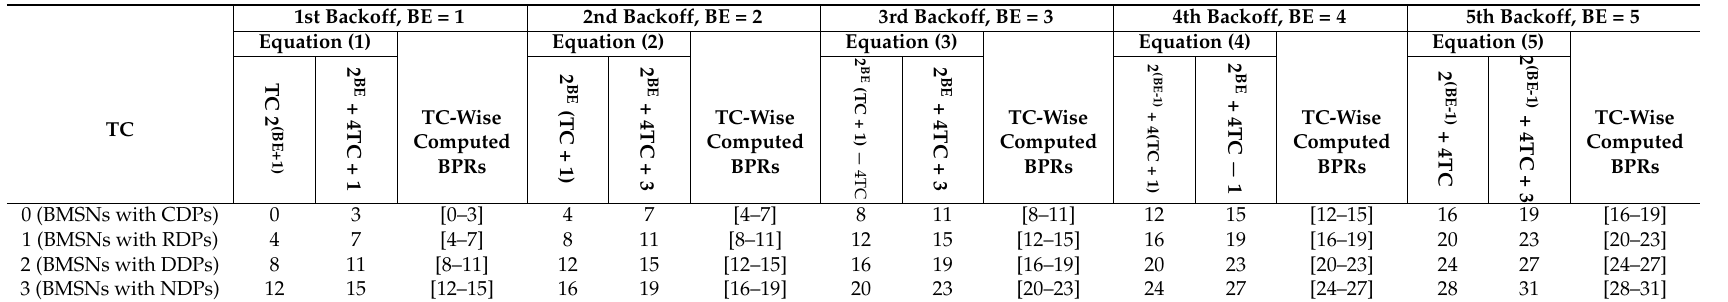
Table 2. Traffic class (TC)-wise computed backoff period ranges used by bio-medical sensor nodes (BMSNs) for the selection of the random backoff number in various